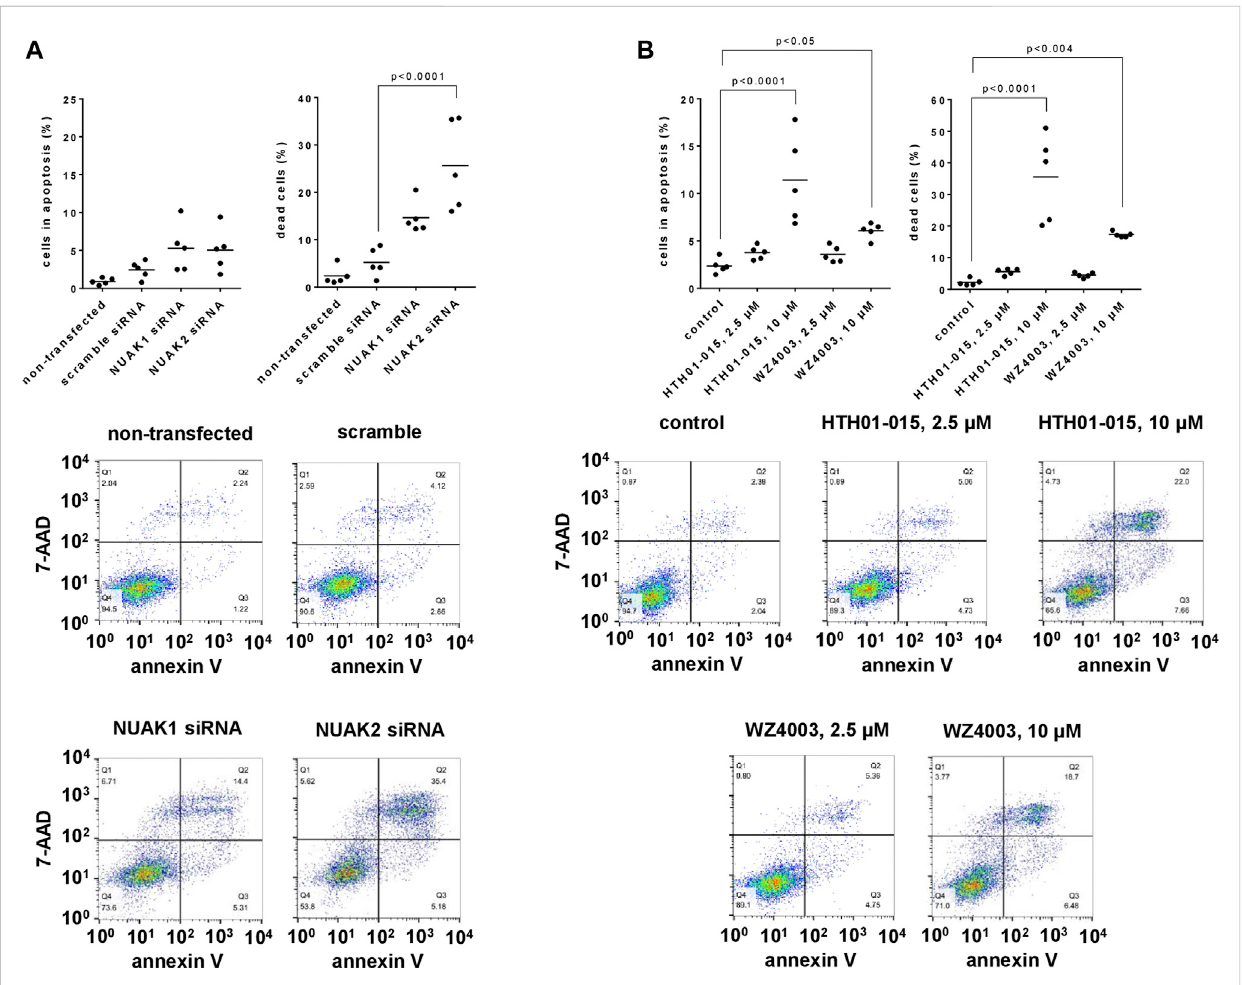
FIGURE 4 Effects of NUAK silencing, HTH01-015 and WZ4003 on apoptosis and cell death of WPMY-1 cells. Apoptosis and cell death were determined by fl owcytometry for annexin V and 7-AAD, 48 h after transfection with scramble siRNA or isoform-speci fi c NUAK siRNAs (A) , or 24 h after addition of HTH01-015, WZ4003 or solvent to controls (B) . Annexin V-positive/7-AAD-negative cells represent apoptotic cells, wheras annexin V-positive/7-AAD- positivecellsrepresentdeadcells.Shownarescatterplotsincludingallsinglevaluesfromeachindependentexperimenttogetherwith p valuesfrom one-way ANOVA with Tukey ’ s test in (A) , and from one-way ANOVA with Dunnett ’ s test in (B) , and representative